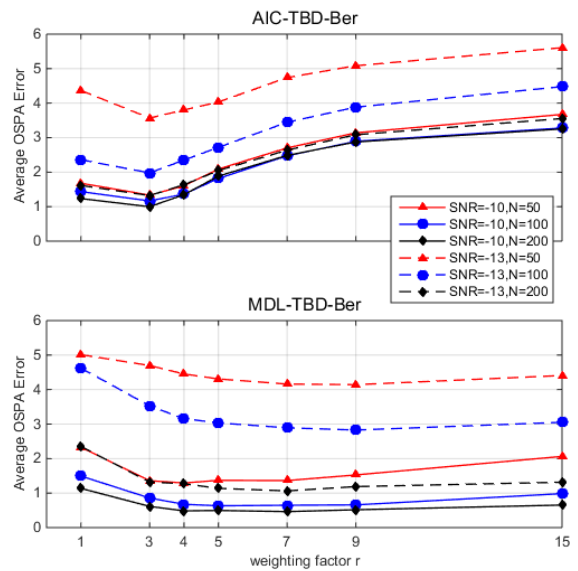
Figure 1. Optimal sub-pattern assignment (OSPA) error averaged over time steps (100 Monte Carlo runs) versus different weighting factors r = [1, 3, 4, 5, 7, 9, 15]. Akaike information criterion track-before-detect Bernoulli filter (AIC-TBD-Ber); minimum description length track-before-detect Bernoulli filter (MDL-TBD-Ber); signal-to-noise ratio (SNR).